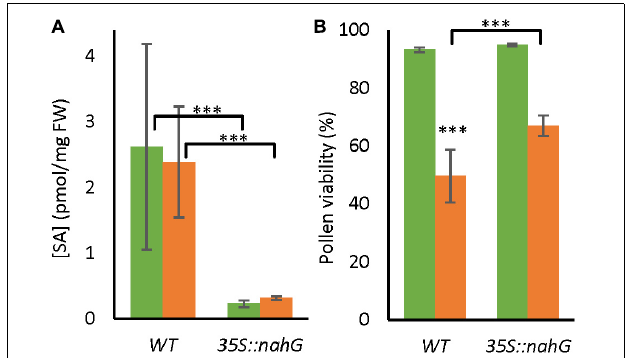
FIGURE 1 | Endogenous salicylic acid (SA) levels and pollen long-term mild heat (LTMH) tolerance of WT and 35S:nahG . Green bars represent control temperature (CT), orange bars LTMH. (A) SA levels in bicellular pollen stage anthers of wild type (WT) and 35S:nahG after exposure to LTMH. LTMH consisted of repeated exposure to 34 ◦ C (day) and 28 ◦ C (night). Hormone concentrations were measured after 7 days of exposure to the treatment. Values indicate the mean ± SD ( n = 6 samples, with pools of 20 anther cones per sample). Two-way ANOVA main effects: temperature ns; genotype